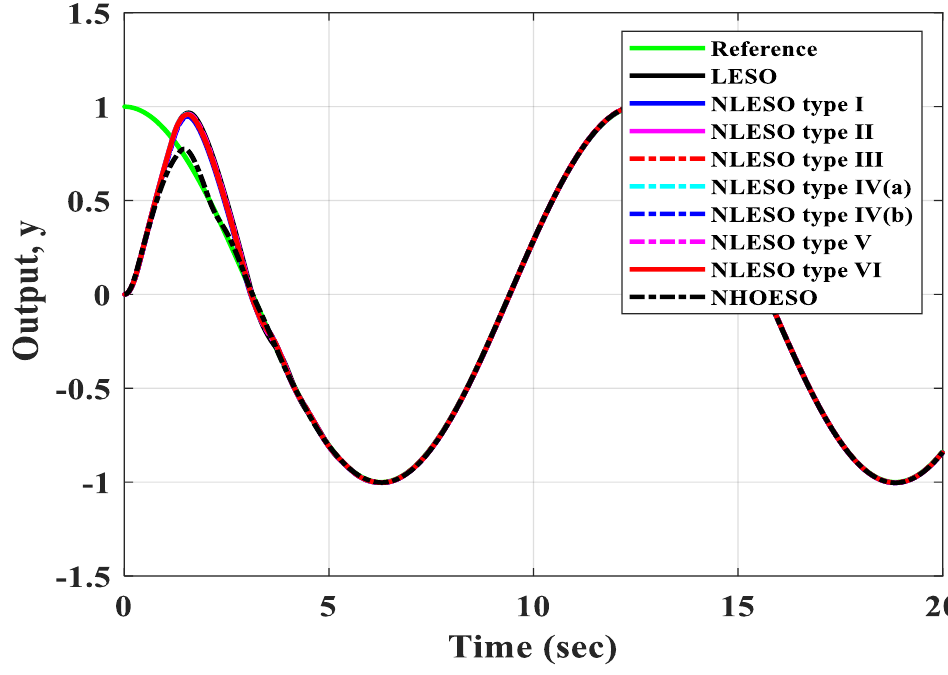
Figure 1. The output response of the system of equation (25).